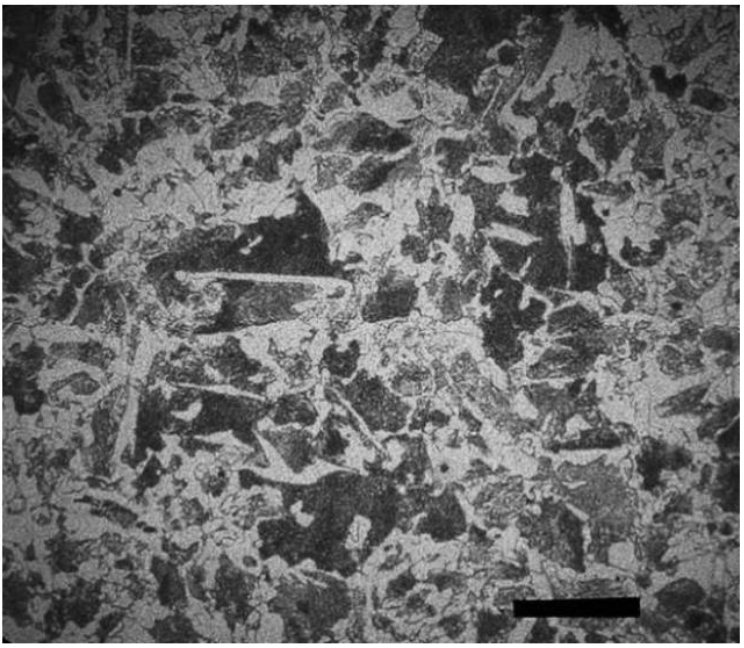
Figure 3. Metallographic facet of the steel (magnified 250 times, etched in nital). A number of facts can be ascertained from the microstructural analysis of the steel.